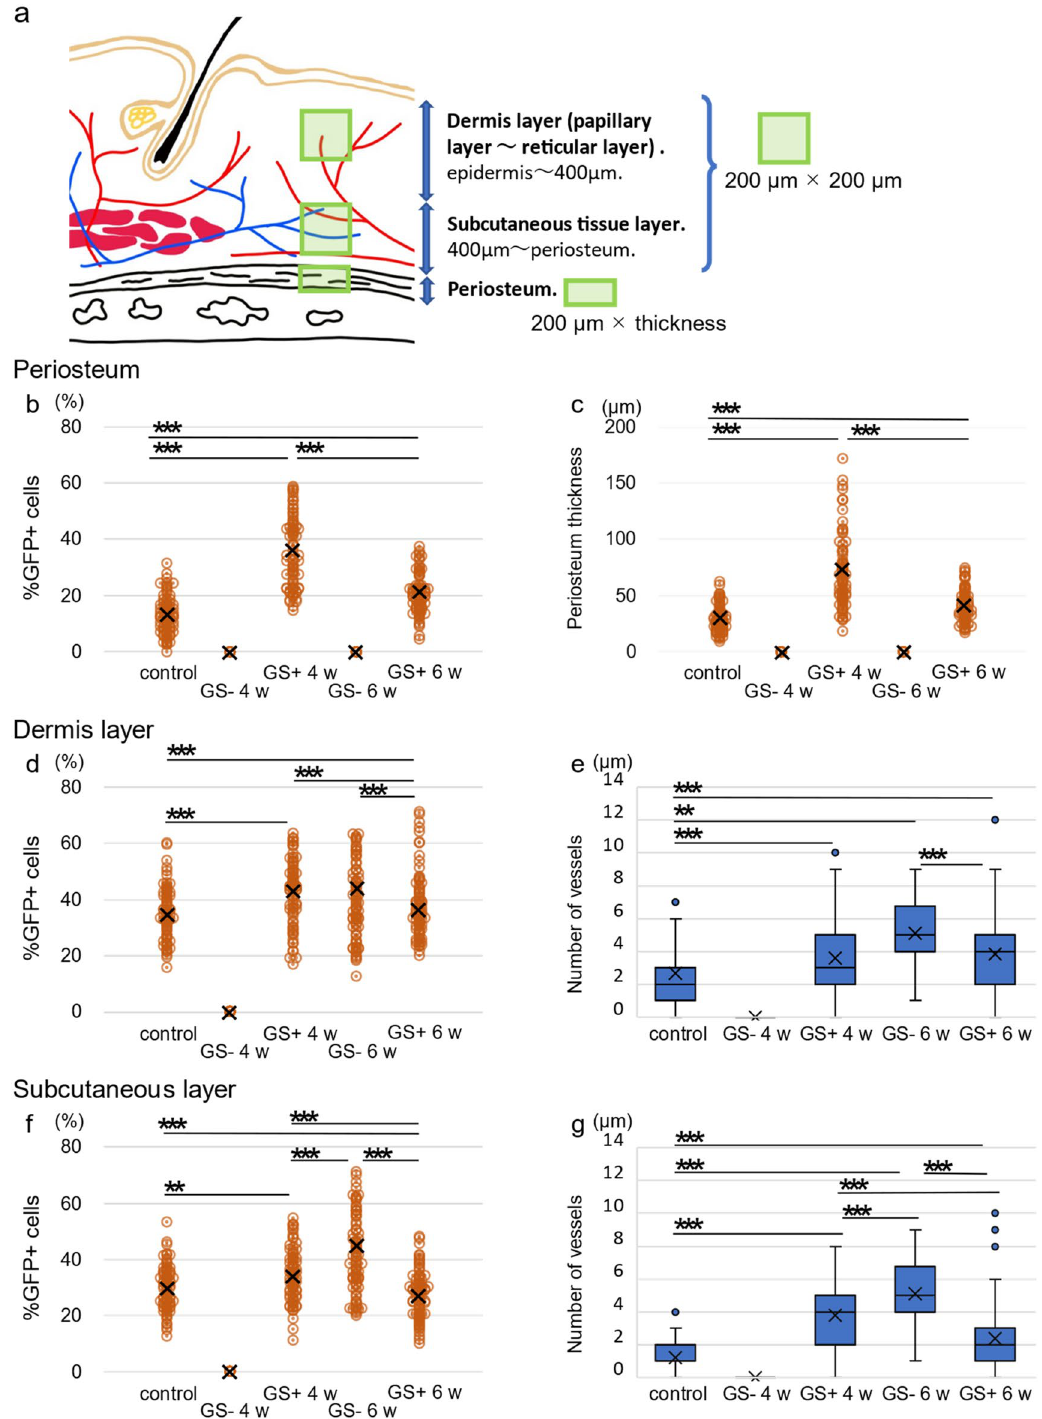
Figure 5. Quantitative analyses in regenerating tissue due to GS application. ( a ) Schema of the tissues in the rat calvaria. The dermis is defined as the tissue from the epidermis–dermis junction to a depth of 400 μm, and from there to the periosteum, it is further defined as subcutaneous tissue. The green areas of either squares or rectangles were analysed. ( b , c ) The changes in the rates of GFP migration into the periosteum and the periosteal thickness in control (unwounded healthy BMT rats), GS (−), and GS (+) rats at 4 w and 6 w pw. ( d , e ) The changes in the rates of GFP migration into subcutaneous tissues and the numbers of vessels in control, GS (−), and GS (+) rats at 4 w and 6 w pw. ( f , g ) Changes in the rates of GFP migration into the dermis and the numbers of vessels in control, GS (−), and GS (+) rats at 4 w and 6 w pw. The cross of each scatter or box plot indicates average value. The upper or lower whisker of each box plot indicates maximal or minimal value, respectively. n = 4 for each. The experiments were repeated twice. P < 0.05, ** P < 0.01, *** P <